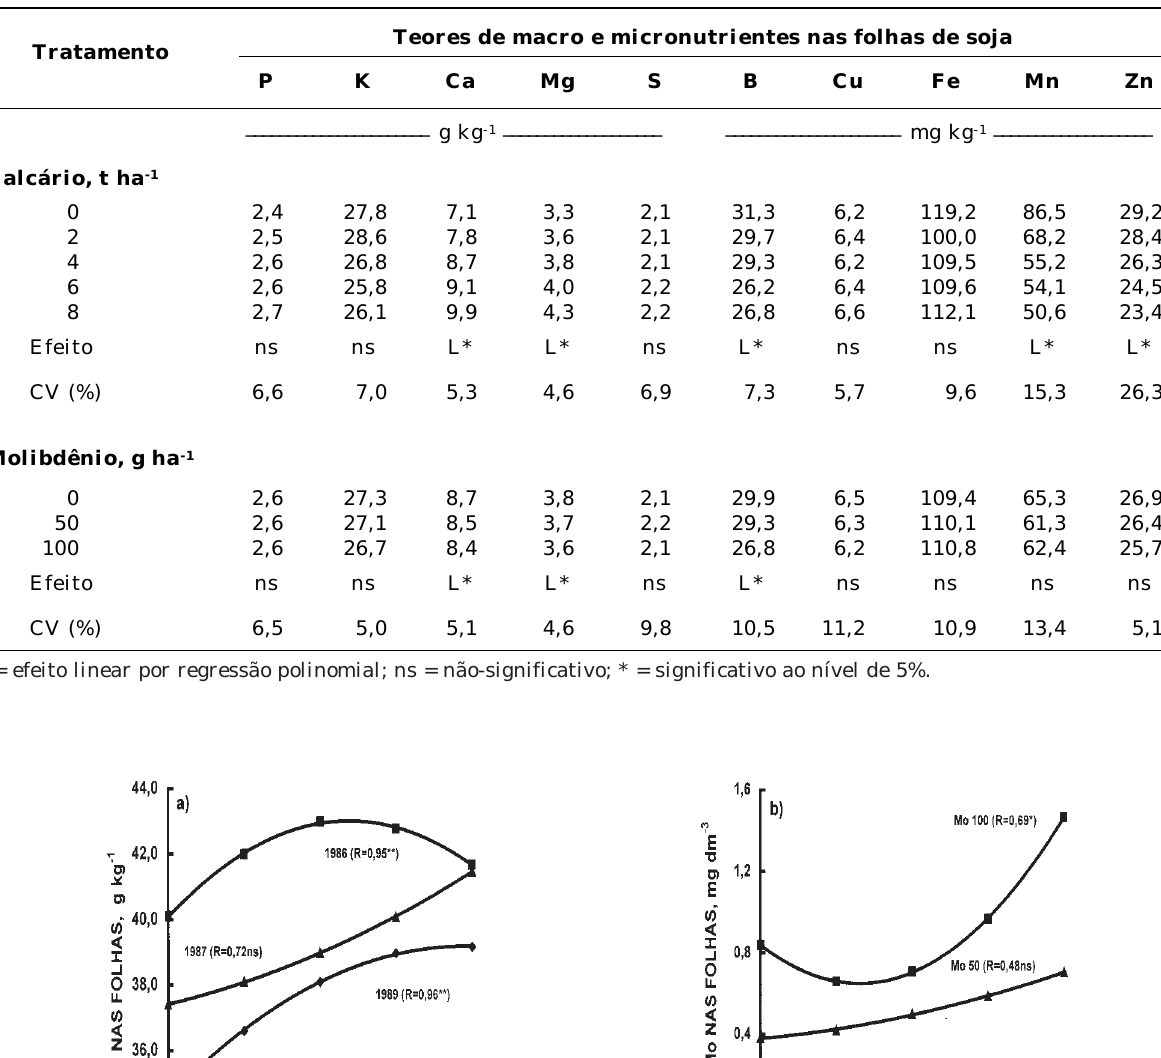
CALCÁRIO, t ha -1 Figura 4. Influência da calagem sobre (a) os teores de nitrogênio e (b) os teores de molibdênio nas folhas de soja (IAC 11).